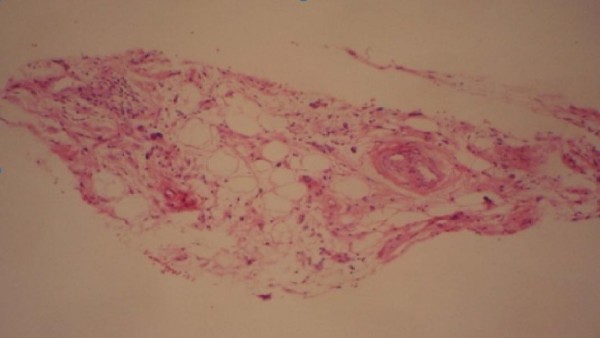
Well-differentiated sclerosing liposarcoma.